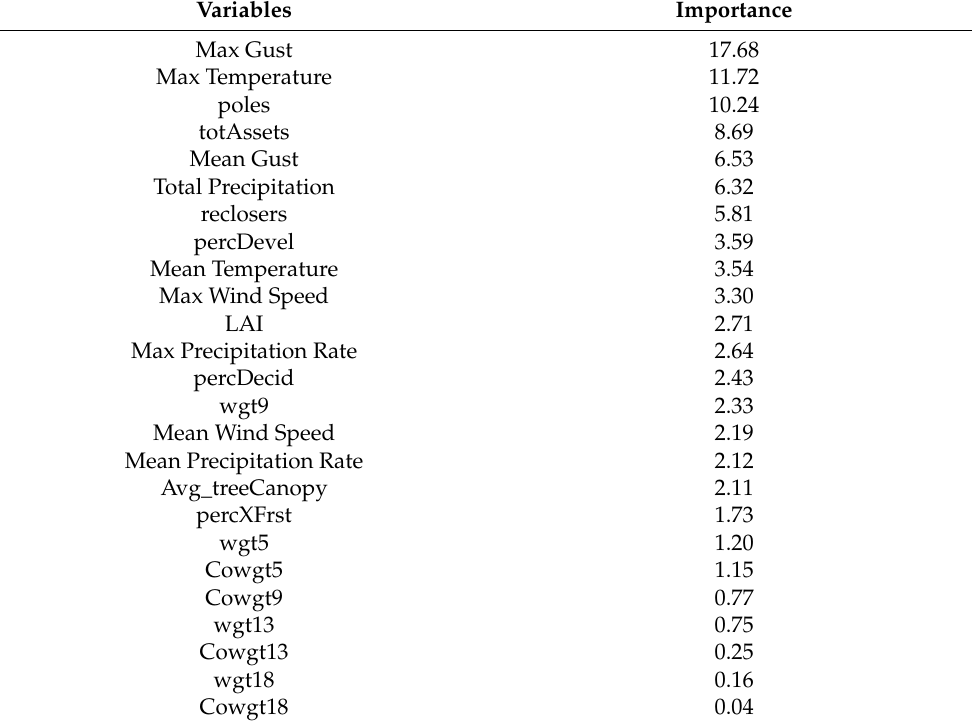
Table 1. Variable